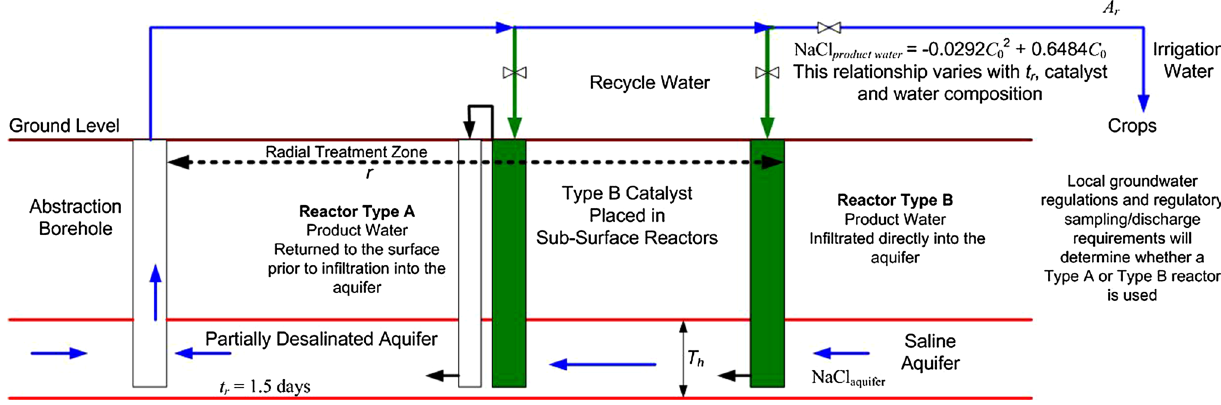
Fig. 15 Process flow diagram for the partial desalination of an aquifer using a Type B catalyst and sub-surface-based